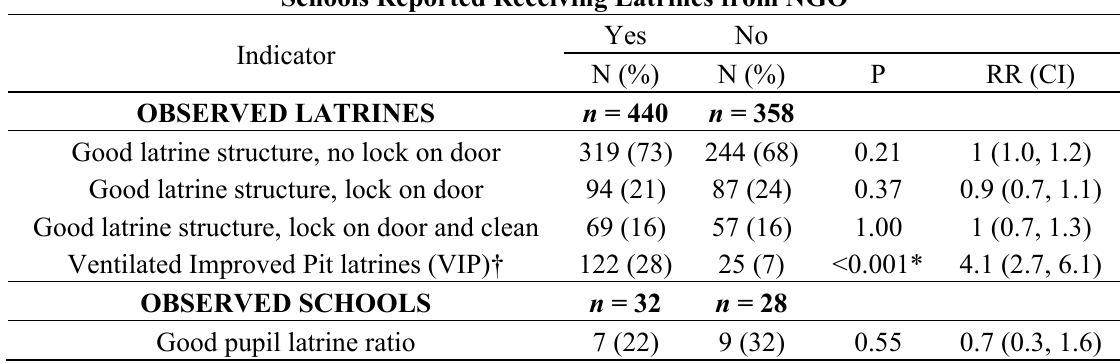
Table 3. Association between latrine conditions in schools and whether latrines were provided by